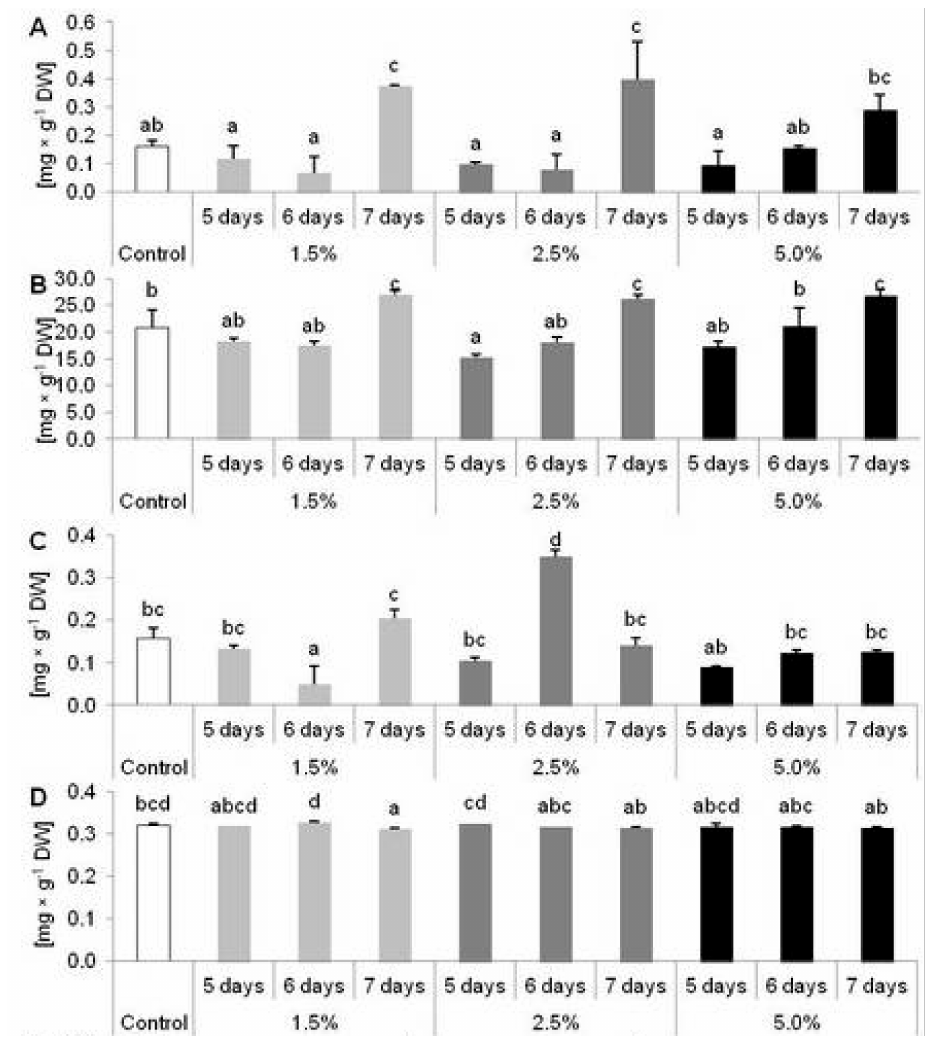
Figure 6. Accumulation of plumbagin in Dionaea muscipula plants after 5, 6 and 7 days of elicitation with Cronobacter sakazakii lysate in different concentrations; different letters—significant difference between means at p < 0.05; bar—standard deviation.